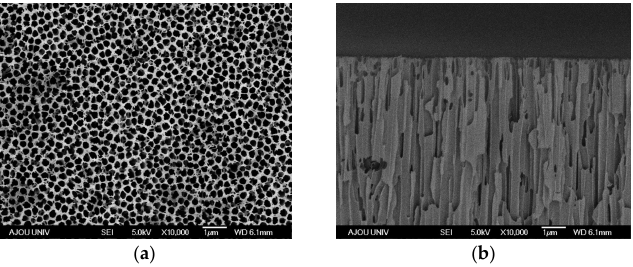
Figure 2. Scanning Electron Microscope (SEM) photos of the porous alumina substrate: ( a ) top view and ( b ) cross ‐ sectional view.